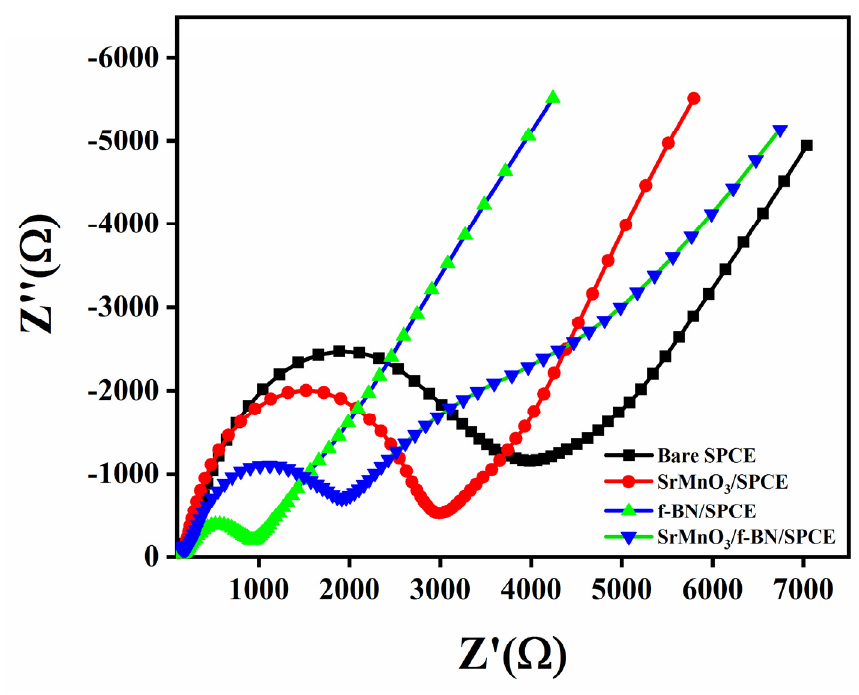
Figure 3. Nyquist plots of bare SPCE, SrMnO 3 /SPCE, f-BN/SPCE, and SrMnO 3 /f-BN/SPCE in 5 mM [Fe(CN) 6 ] 3 − /4 − with 0.1 M KCl solution.